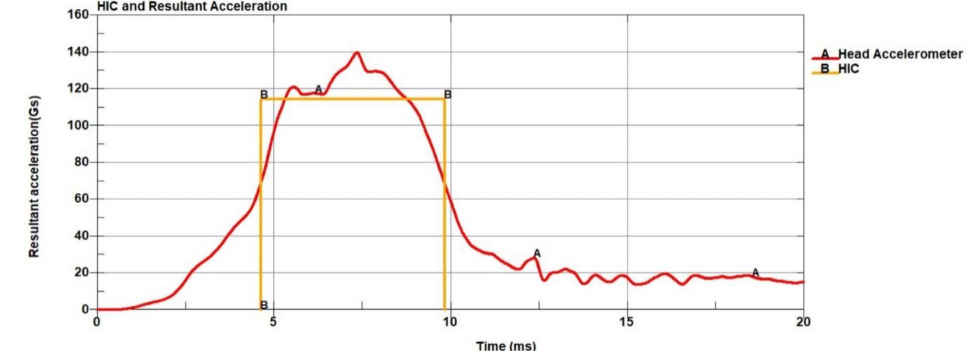
Figure A16. The course of simulation (0–20 ms, 5 ms interval) in configuration R.